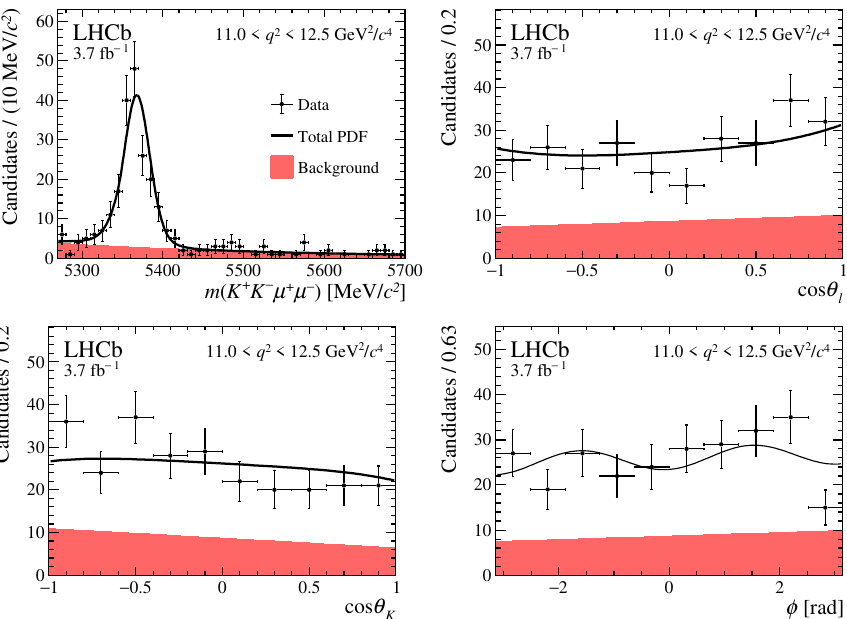
Figure 26 . Mass and angular distributions of B 0 11 . 0 < q 2 < 12 . 5 GeV 2 /c 4 for data taken in 2017–2018. The data are overlaid with the projec- tions of the fitted PDF.